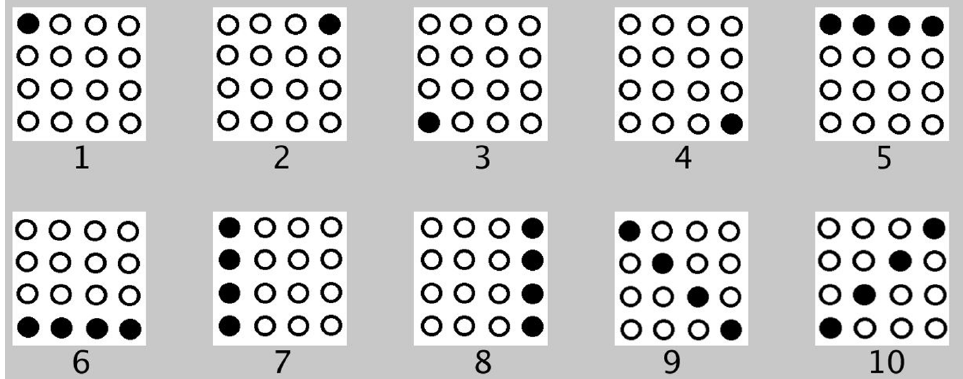
Figure 18. Patterns for spatial test.